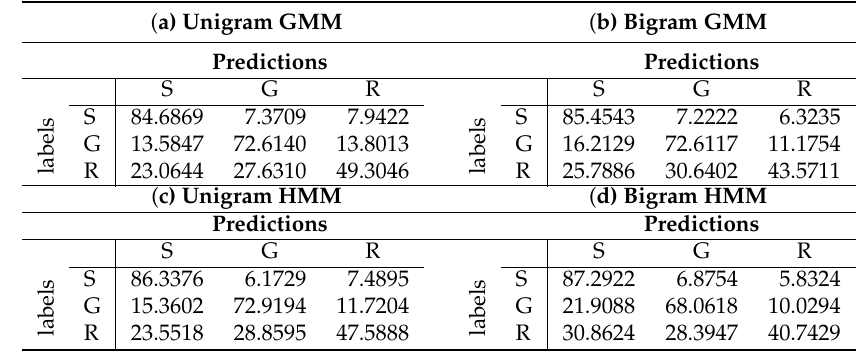
Table 2. Normalized confusion matrices for the four classification methods when using 5 mixture components. Rows are ground truth (kinematic) labels; columns are predicted labels; and S, G and R correspond to steady, grasp and release labels. All values are percents, and values along the main diagonal are correct predictions. Steady states occur most often; this means that the subject is not in any of the other states.